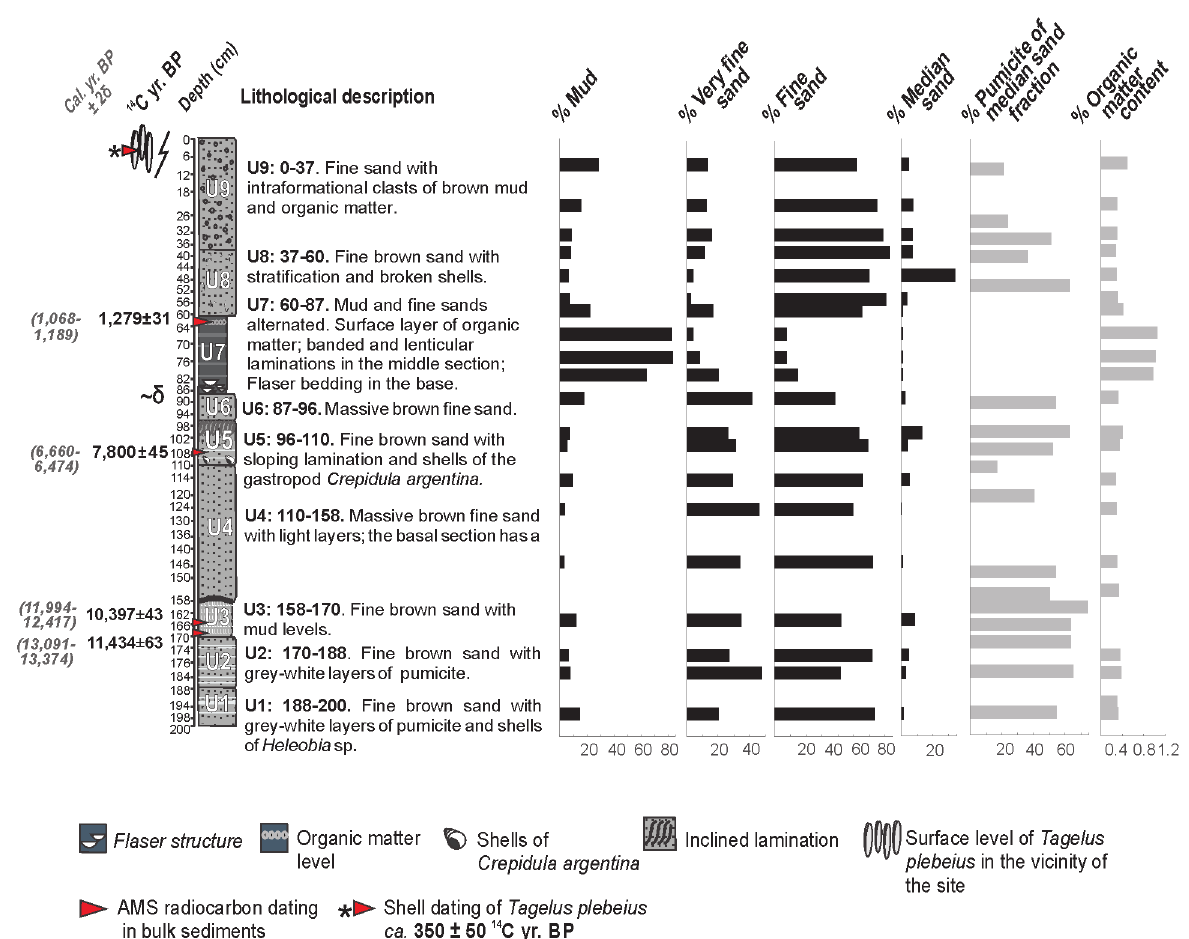
Figure 2. Lithological profile and granulometric analysis of LCH core. The grain size categories are: very fine, fine, median sand and mud (%). Additionally, it shows pumicite of median sand and organic matter in percentages